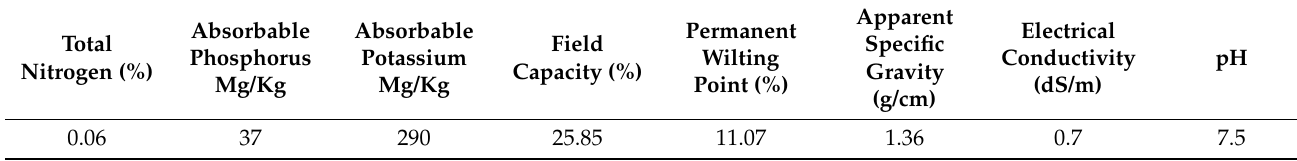
Table 1. Physicochemical characteristics of the soil